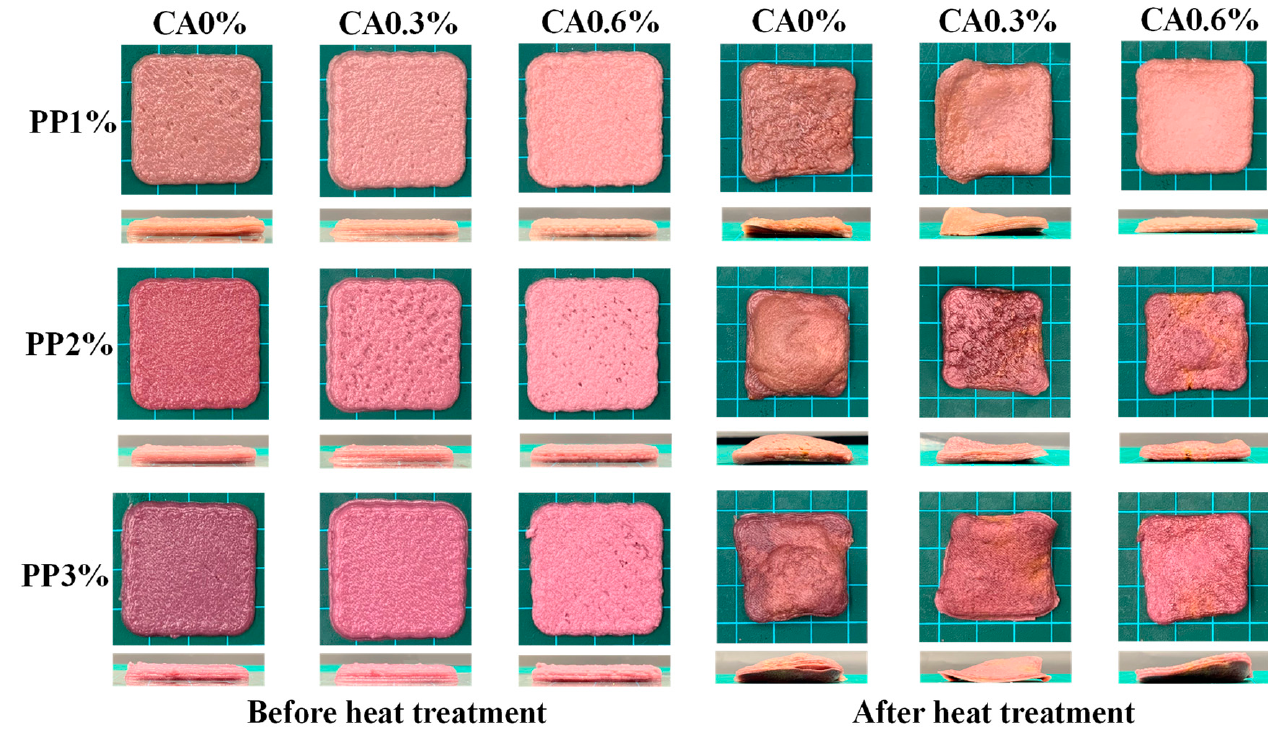
Figure 2. Printing quality of restructured mackerel mince.